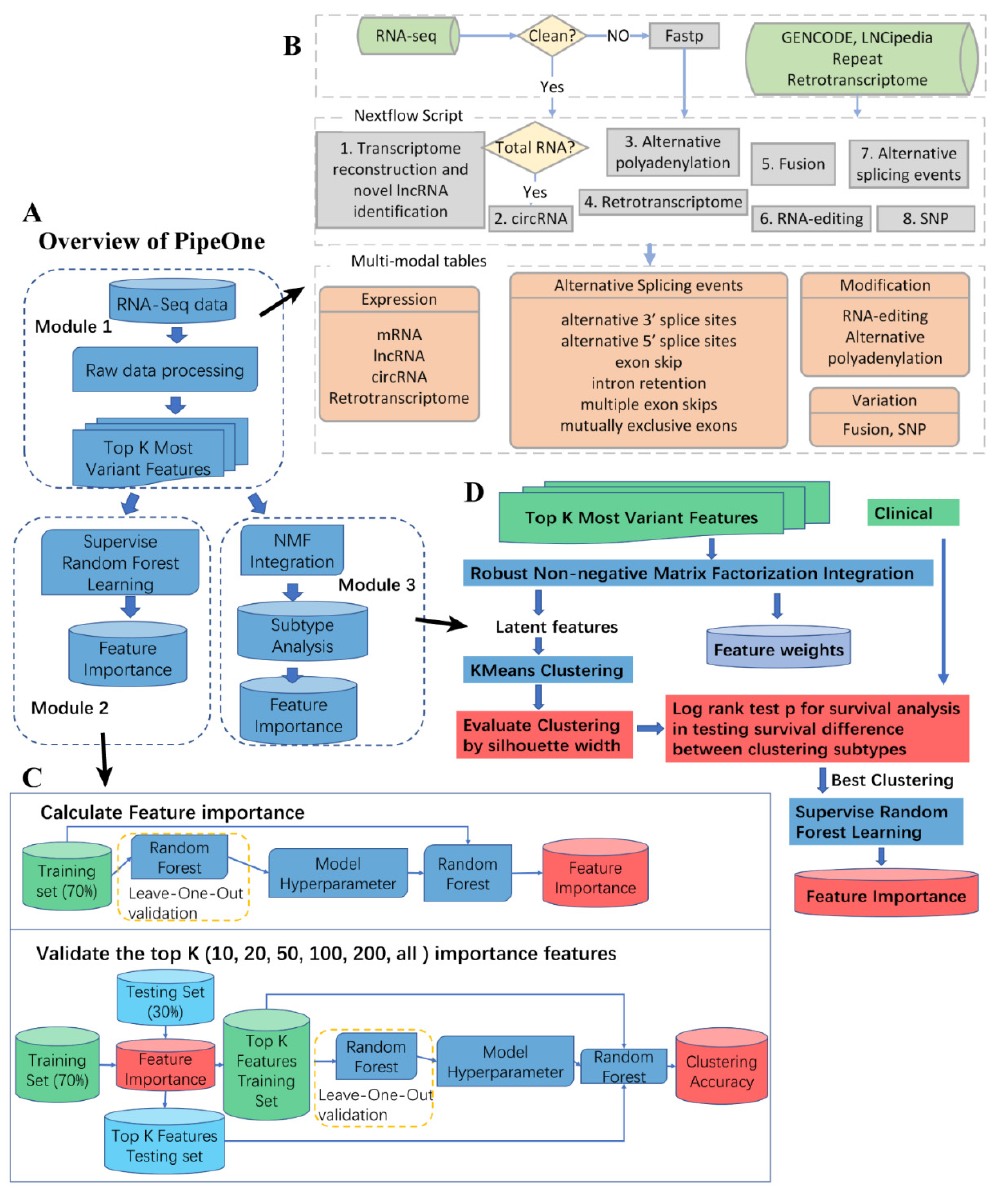
Figure 1. Overall design of PipeOne. ( A ) Three modules of PipeOne: data processing and various feature identification (one), feature prioritizing (two), and disease subtyping (three). ( B ) Details of module one. Raw sequencing reads were quality controlled by FASTP and then went through eight tools to extract information from RNA-seq data, including expression levels of mRNA, lncRNA, circRNA, and retrotransposons, alternative splicing events, alternative polyadenylation, RNA editing, gene fusions, and SNPs. These information was used to construct the feature matrices for machine learning (only the top 1000 most variable features were used for each type of information) in module two and three. ( C ) Details of module two. First, feature importance was calculated by using random forest on all features from module one. Then the top K (20, 20, 50, 100, 200, all) ranked by feature importance were used to test and validate the importance of those top features. ( D ) Details of module three. First, a robust NMF integration algorithm was applied to obtain latent features and associated weights for all samples. Then K-Means clustering evaluated by silhouette width was used to cluster samples based on the latent feature matrix. Differential survival analysis by log-rank test was used to assess the clinical relevance of those stable clusters as potential subtypes. Finally, similar to module two, random forest was used to select features contributing to the subtyping